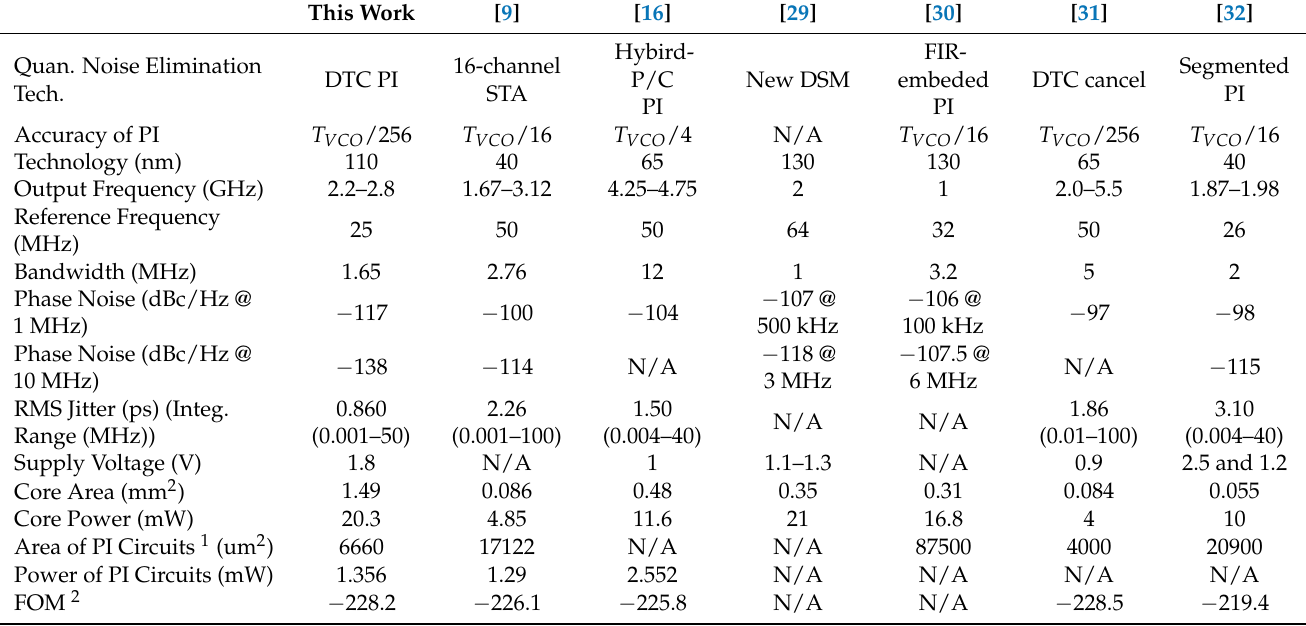
Table 2. Summary and